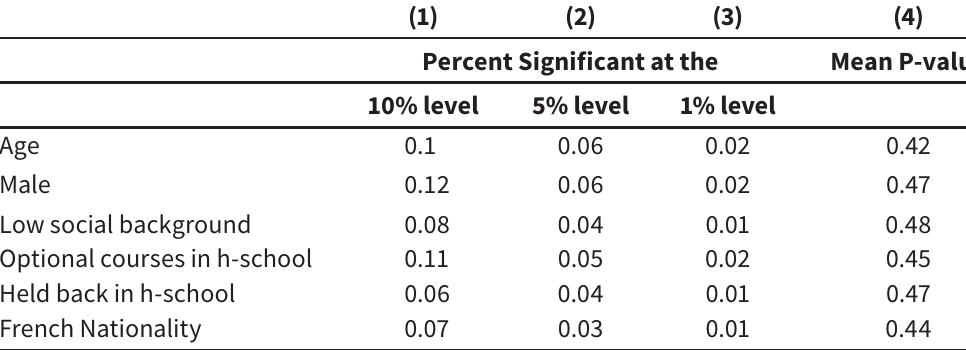
Randomization check of high school class assignment